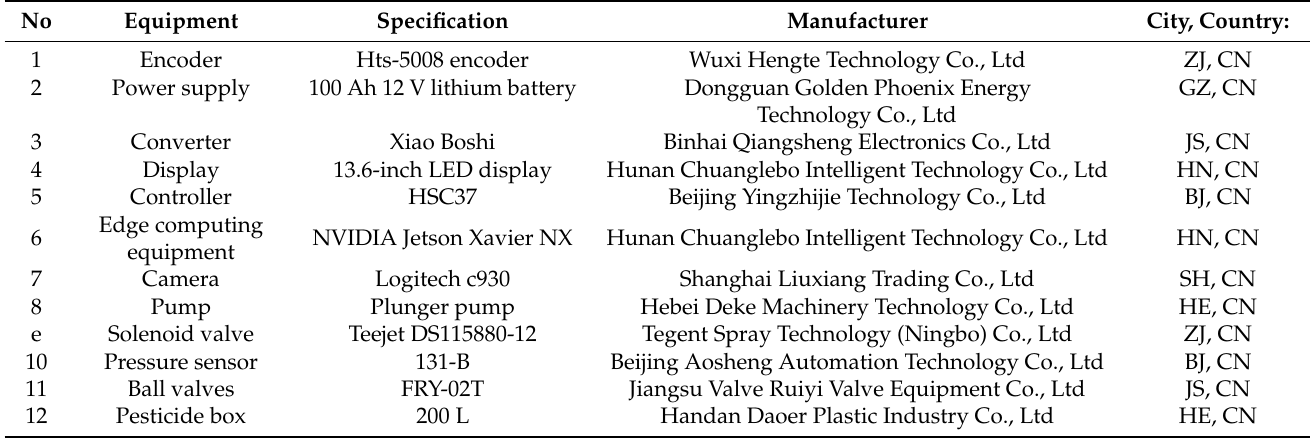
Table 1. Equipment model of the target-oriented spray system.